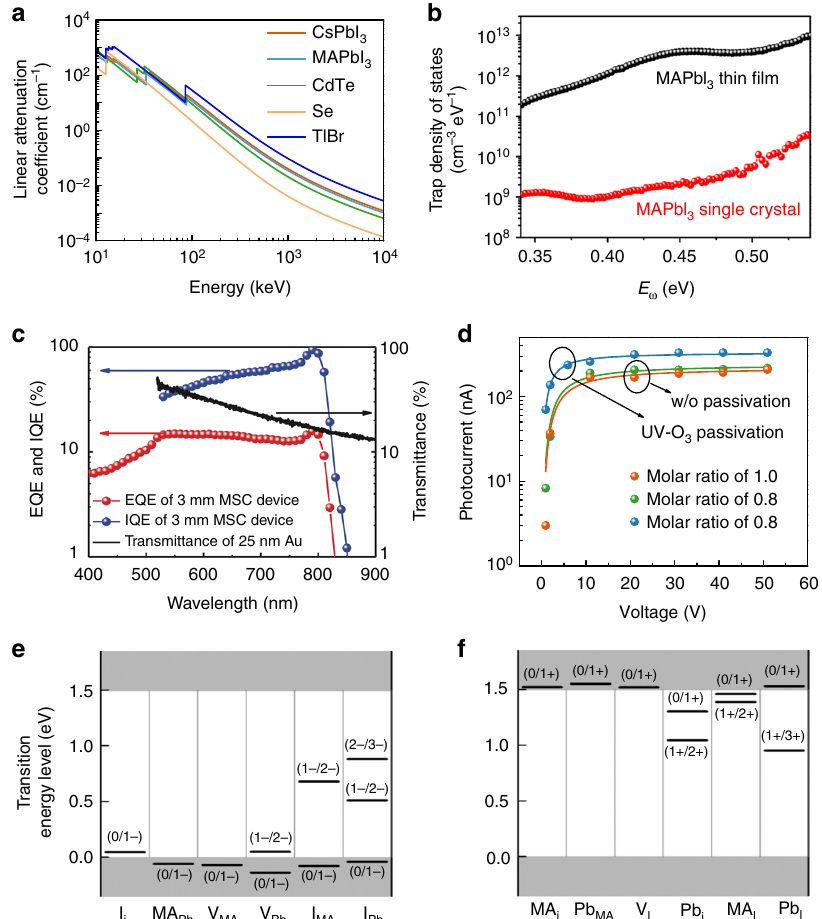
Fig. 1 Electronic properties of halide perovskites. a Linear attenuation coef fi cient of MAPbI 3 , MAPbBr 3 , CdTe, Se, and TlBr versus photons energy. b Trap density of states of the MAPbI 3 single crystal (red dots) and the thin fi lm (black dots) measured by thermal admittance spectroscopy at room temperature. c External quantum ef fi ciency (EQE) and internal quantum ef fi ciency (IQE) spectra of a 3-mm-thick MAPbI 3 single crystal along with the transmittance of 25-nm-thick gold electrode. d The µ τ product of MAPbBr 3 crystal devices with different raw materials feeding ratio and surface passivation procedure. The transition energy levels of e intrinsic acceptors and f intrinsic donors in CH 3 NH 3 PbI 3 perovskite. b , c are adapted with permission from ref. 43 , AAAS. d is adapted with permission from ref. 18 , Springer Nature. e , f are adapted with permission from ref. 49 , American Institute of